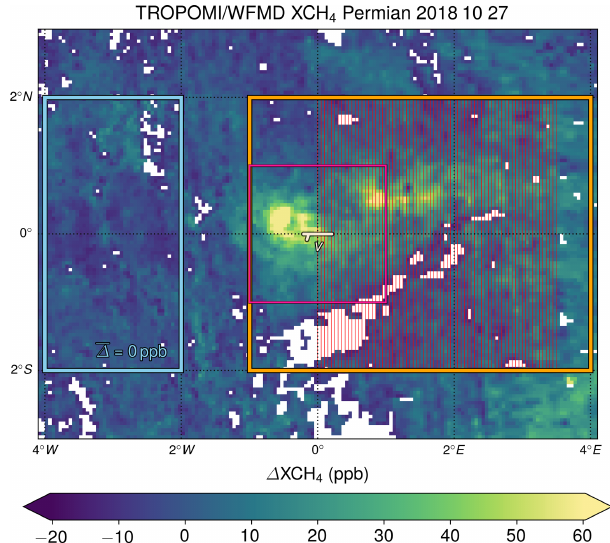
Figure 2. Example daily data to illustrate the estimation of the emis- sion. The coordinate system has been transformed so that the wind direction lies along the Equator. The background region is shown in sky blue, the plume region in orange, and the hot-spot region in pink. The extent of these regions is fixed for all analysed days in the rotated coordinate system. By design, the background region has a mean abundance of 0ppb. The meridional sections used to calculate the daily flux are displayed in red.